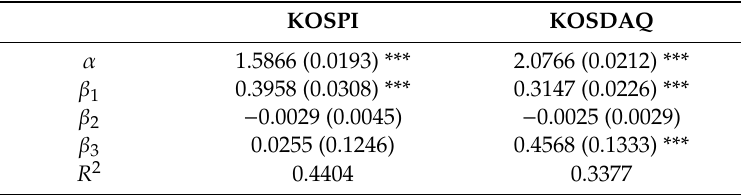
Table 8. Regressions on estimates of herding behavior incorporating investor sentiment.